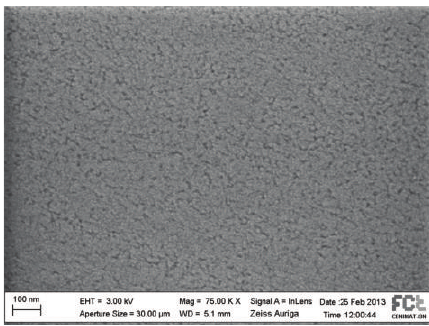
Figure 13: A representative SEM image of the WO 3 film showing the high homogeneity of the deposit at nanoscale level. Table 1: Effect of 10000 cycles of electrochemical switching on ST Δ T% ST B , C , and ( 700nm ) of a typical ECD with the configuration /PE/V O . Each cycle is made of 20s at +2V (bleaching) and WO 3 2 5 20 s at − 2V (coloring). Potentials are versus V counter and reference